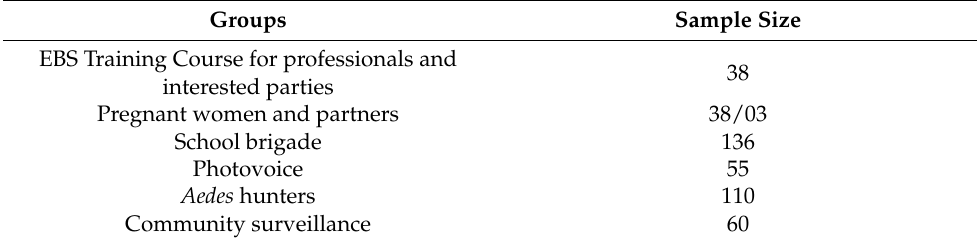
Table 1. Sample size of groups that participated in the intervention.